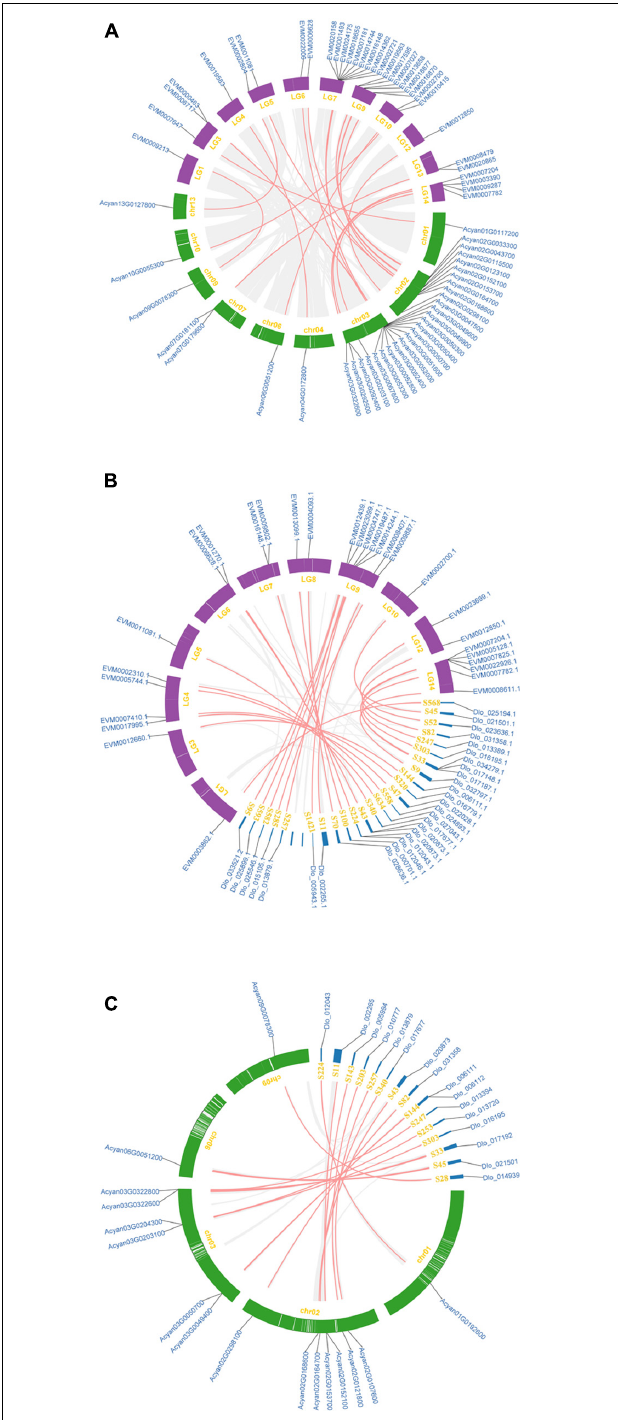
FIGURE 4 | Synteny of the three Sapindaceae species NBS-encoding genes. (A) Synteny of X. sorbifolium and A. yangbiense NBS-encoding genes. (B) Synteny of X. sorbifolium and D. longan NBS-encoding genes. (C) Synteny of A. yangbiense and D. longan NBS-encoding genes. LG1-15, X. sorbifolium chromosomes; chr01-13, A. yangbiense chromosomes; S, D. longan scaffolds. Red and gray lines represent synteny NBS-encoding genes and non-NBS-encoding genes,